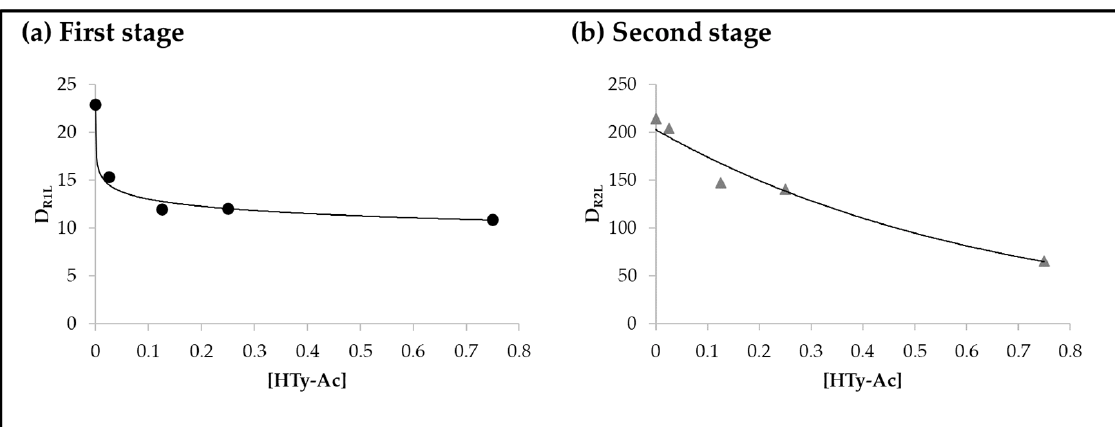
Figure 4. Representation of the degradation rate of linoleic acyl group D R1L in the first ( a ) and D R2L in the second ( b ) stage of its degradation pathway, expressed in mmol mol − 1 TG day − 1 , versus the initial concentration of the antioxidant [HTy-Ac], expressed in percentage by weight, in the different samples. The lines of these figures correspond to the representation of Equations (2) ( a ) and (3) ( b ) respectively.